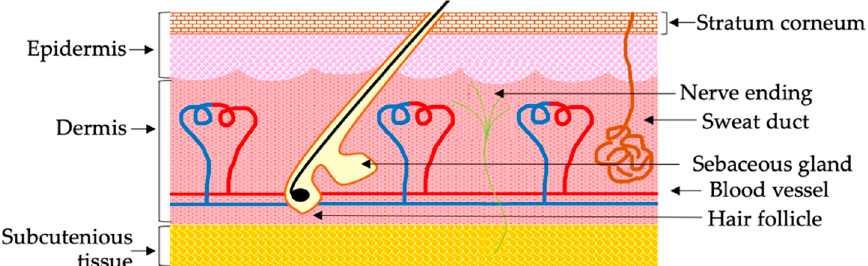
Figure 1. Illustration of mammalian skin. It is composed of epidermis, dermis, and skin appendages (e.g., hair follicles, sweat glands, and sebaceous glands). The outermost layer of the epidermis, known as the stratum corneum, provides the skin barrier function. The other components of the skin include blood vessels and nerves.